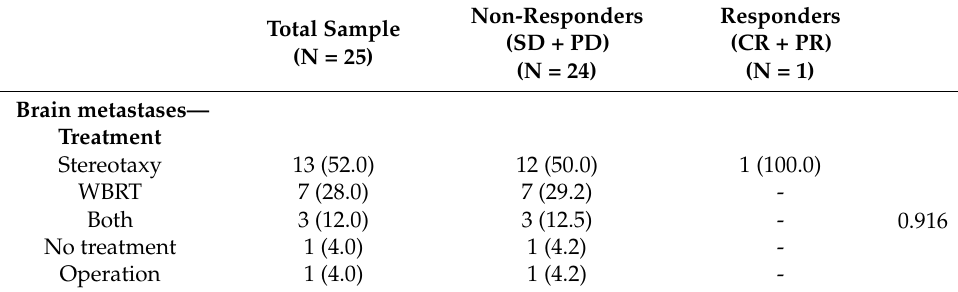
Table 2. Brain metastases.